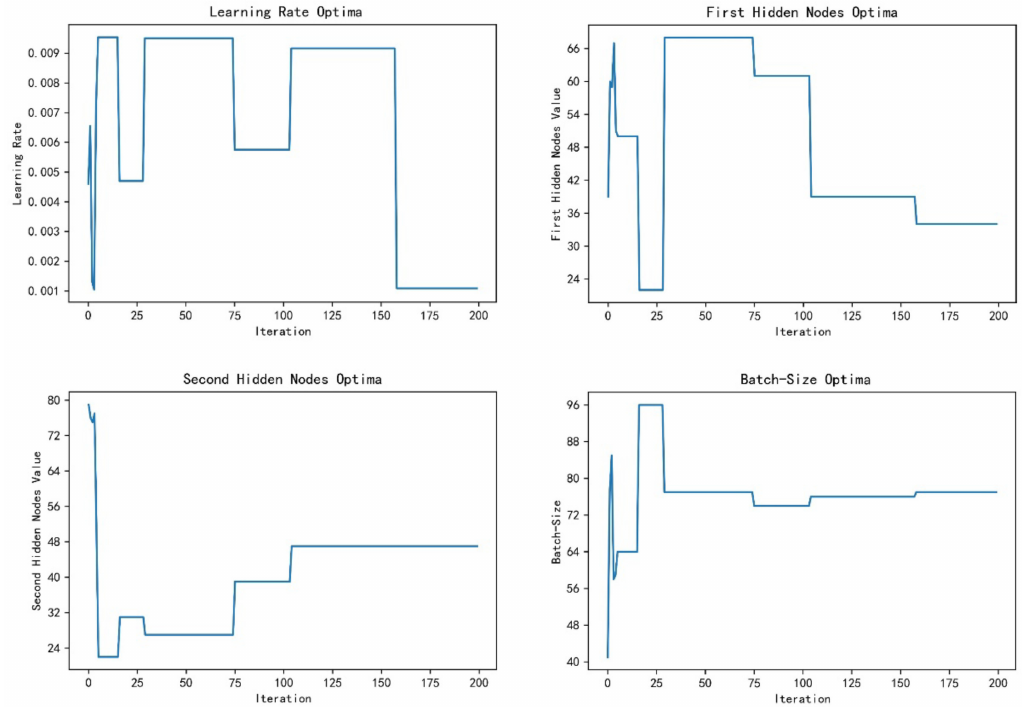
Figure 7. MPSO_ATT_LSTM network hyperparameter search